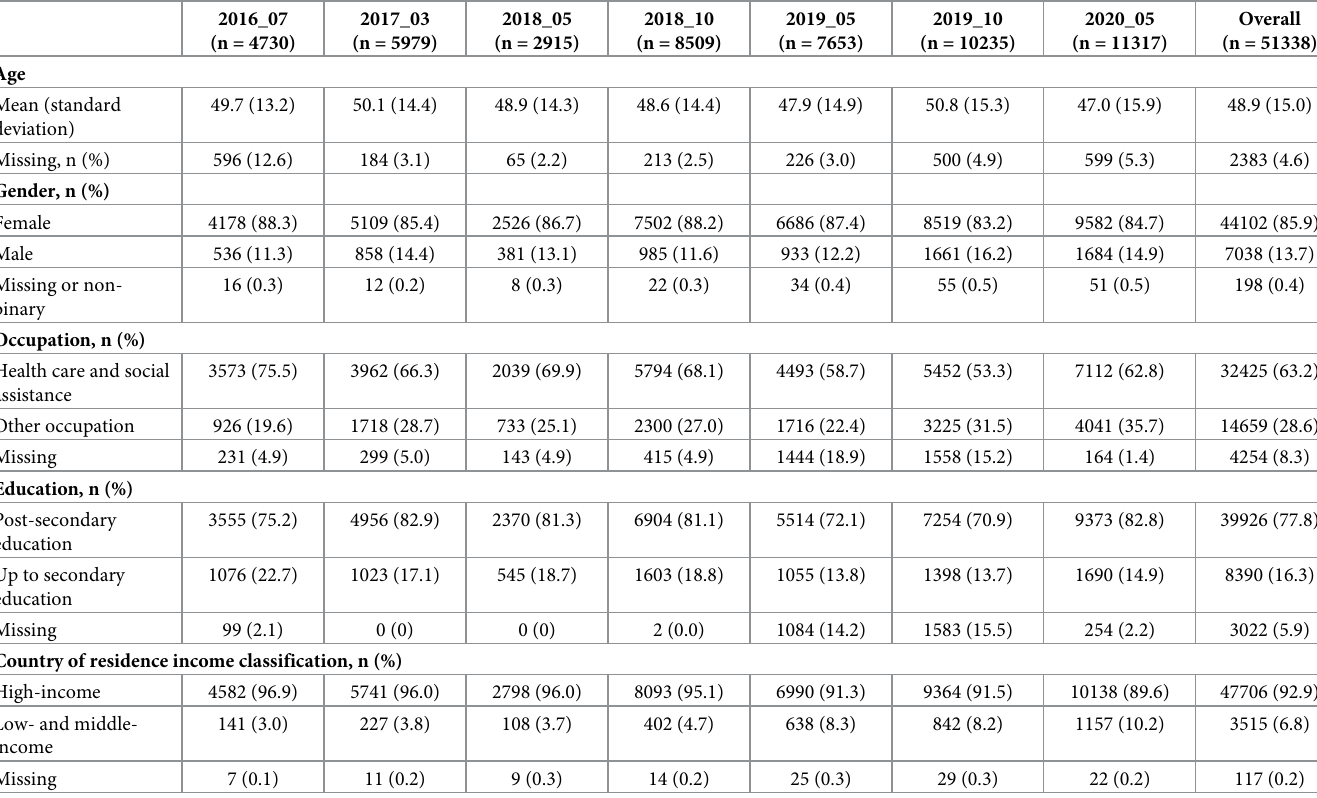
Table 1. Participant demographics.